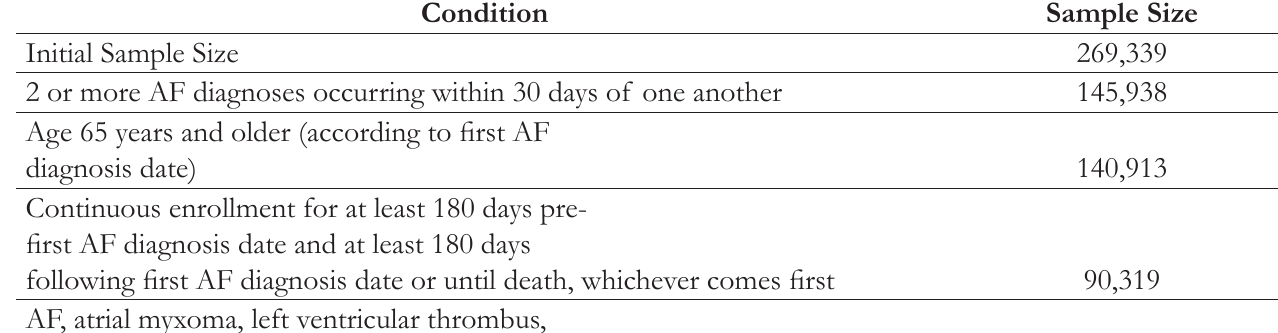
Table 1. Attrition